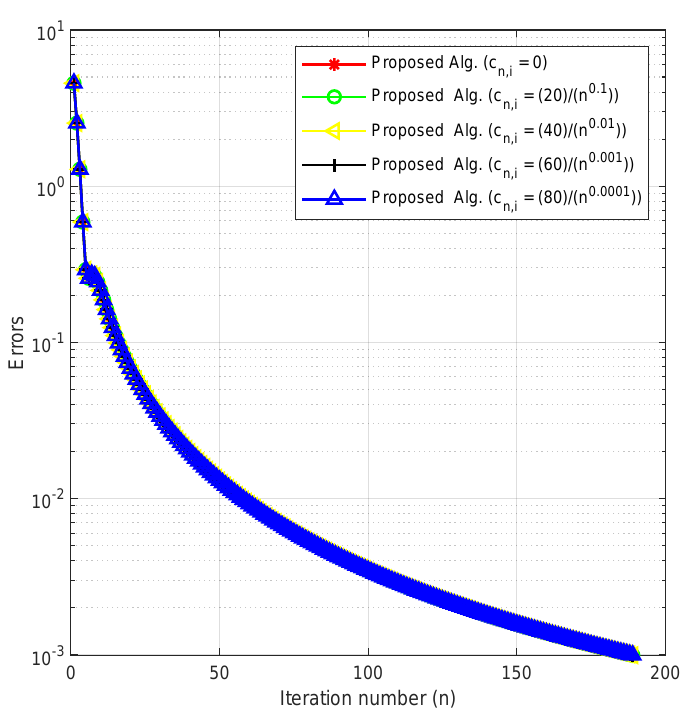
Figure 3. Experiment 1: m = 60.